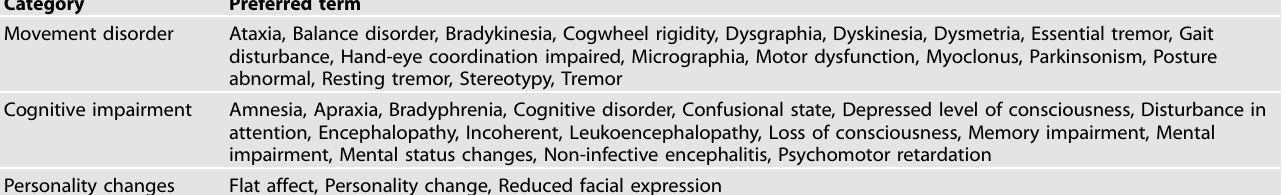
Table 1. Movement and neurocognitive treatment-emergent adverse events in